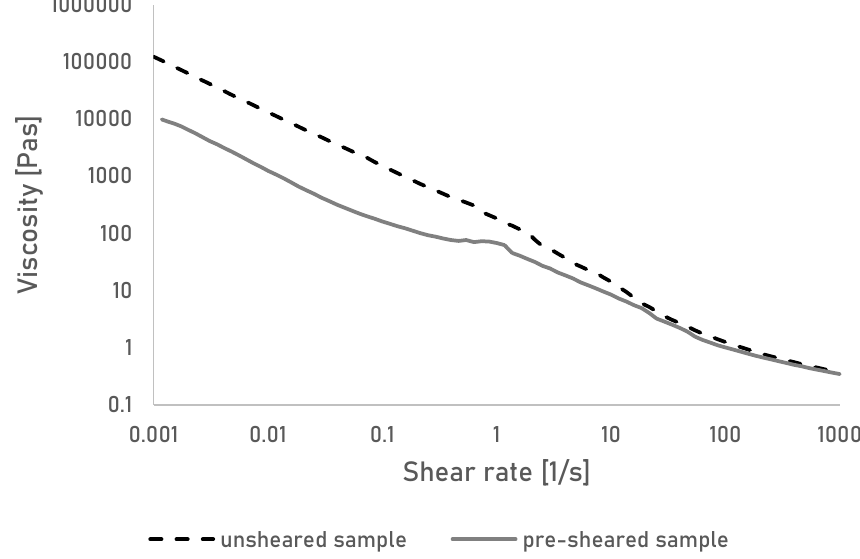
Figure 1. Viscosity of the cellulose gel measured over shear rate. Shown are results of a gel in unsheared and presheared state.